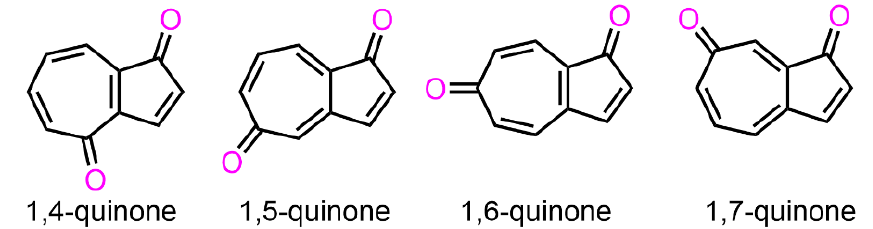
Figure 1. A series of azulenequinones reported by Scott et al.